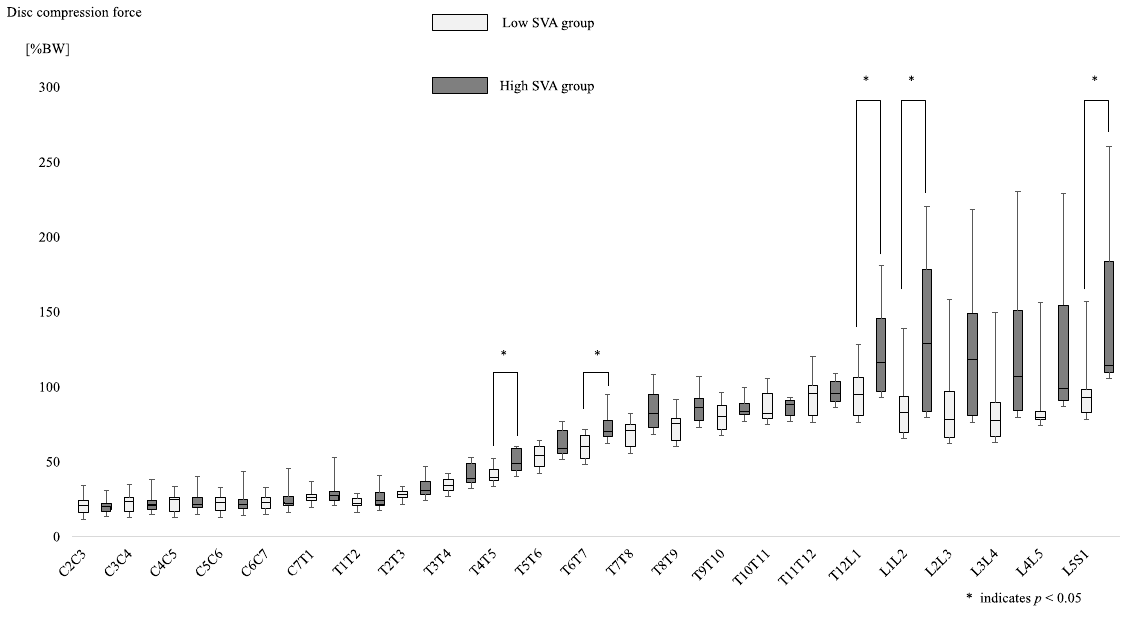
Figure 6 showed 𝐹 (cid:3040) between the two groups at each disc level. Figure 6 showed F m between the two groups at each disc level.